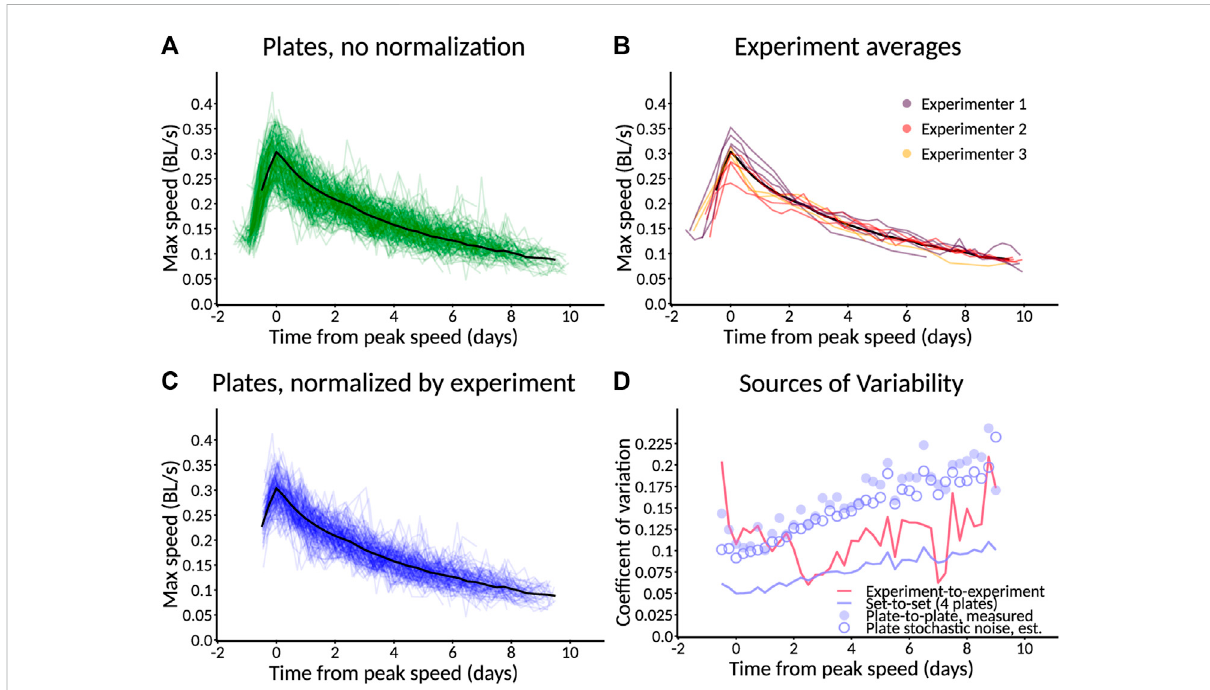
FIGURE 9 Estimation of sources of variability. (A) Measured variation in aroused maximum speed. Scores for 201 individual plates of control animals (green) across 10 experiments, plus population average (black). Typically, 40 – 60 animals per plate. (B) Variation between experiments. Experiment averages (colors) and population average (black) for data in (A) . (C) Variation normalized by experiment. Scores for 154 plates normalized relative to their experiment(blue) byscaling the mean of theexperimentto match the populationaverage (black). Data from (A) , with low-n plates fi ltered out. (D) Relative scale of sources of variability. Variation between experiments (red line) is larger than the variation between a 4-plate set of samples (blue line). Measured plate-to-plate variability ( fi lled blue circles) closely matches expectations from stochastic sampling (open blue circles), indicatingminimalsystematicplate-to-plateeffects.Variabilityisexpressedasthecoef fi cientofvariationcomparedtothepopulationaverage(black lines in (A – C)